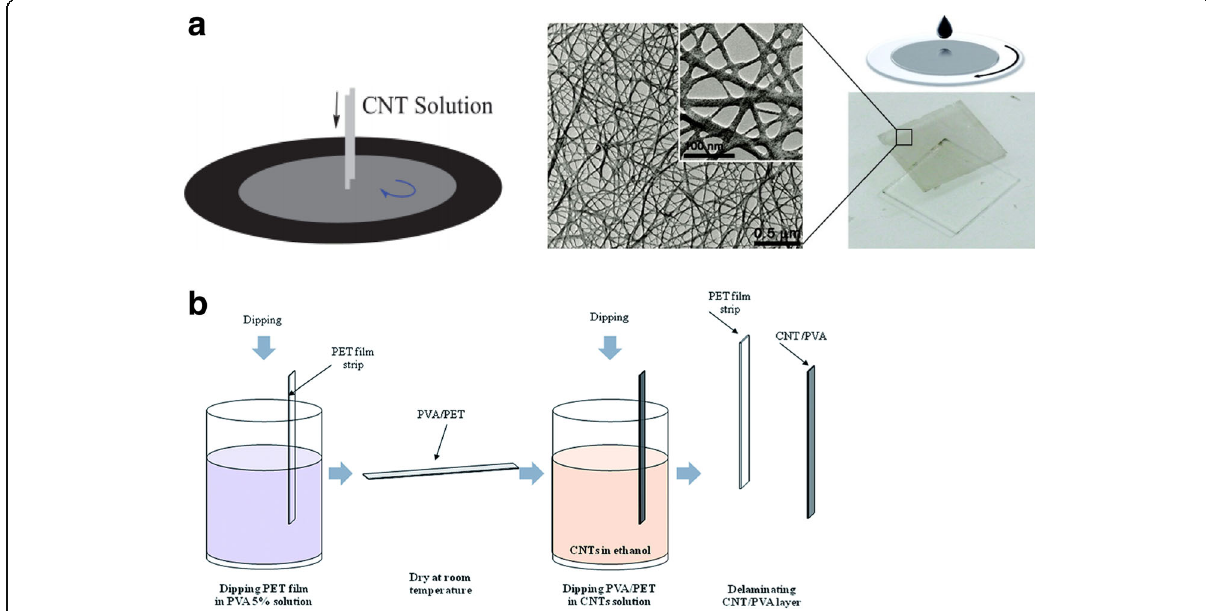
Fig. 33 a Schematic of spin coating process for the fabrication of thin film of CNTs. Adapted from [230]. The corresponding SEM images of the SWCNT film prepared by single deposition of spin coating the substrate with CNT solution in an organic solvent called quinquethiophene-terminated poly (ethylene glycol). Adapted from [229]. b A schematic of a CNT-polymer composite fabrication via solution-based processing. Adapted from